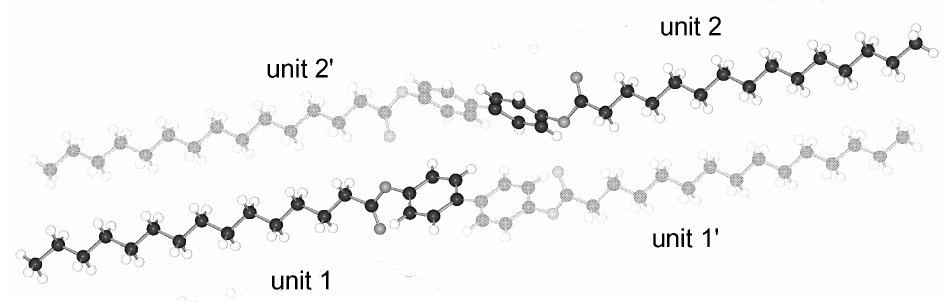
Figure 22. Generation of the two molecules for the structure of BP-14 in space group P-1 by two units 1 and 2 of half a molecule on which inversion symmetry elements are